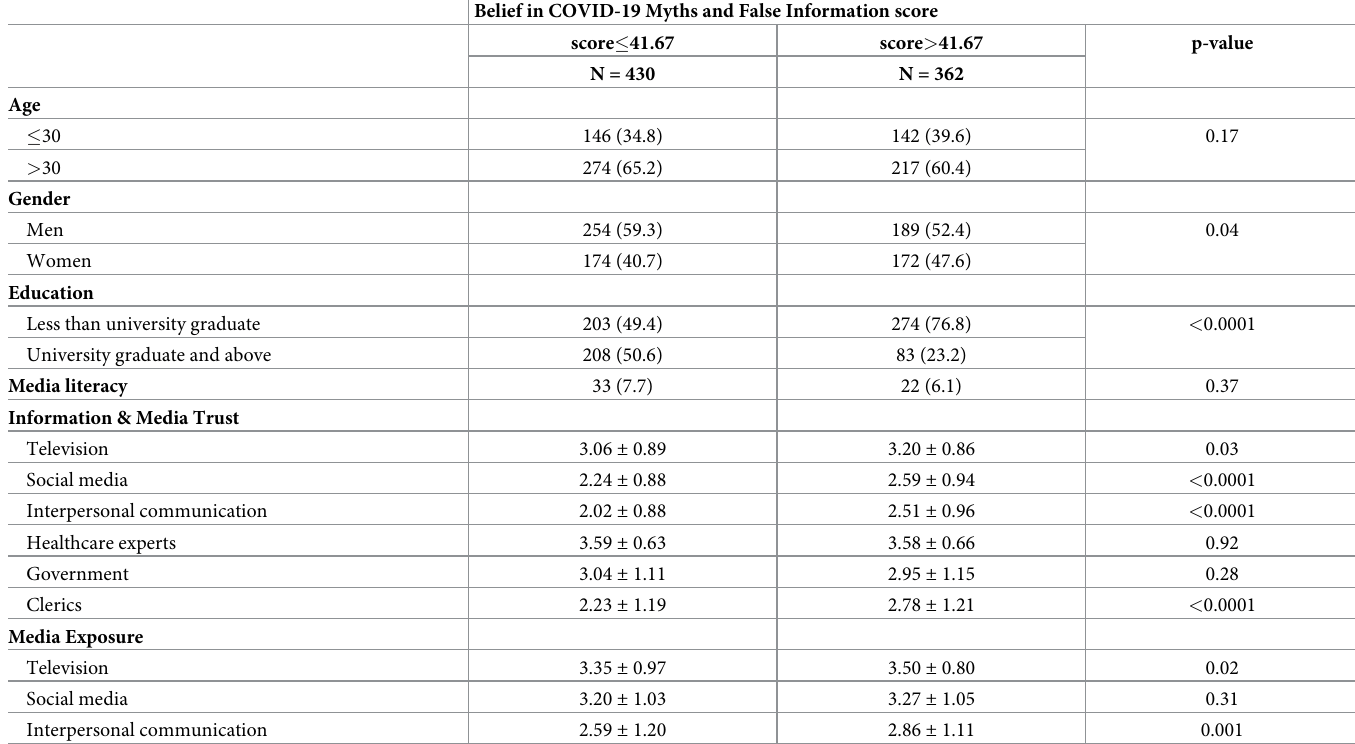
Table 2. Association of trust in media and information sources with myths and false